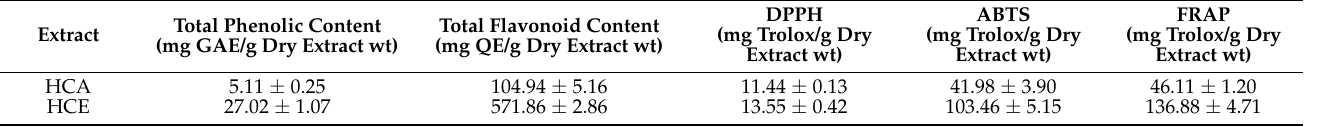
Table 1. Total phenolic content, total flavonoid content, and antioxidant activities of H. cordata